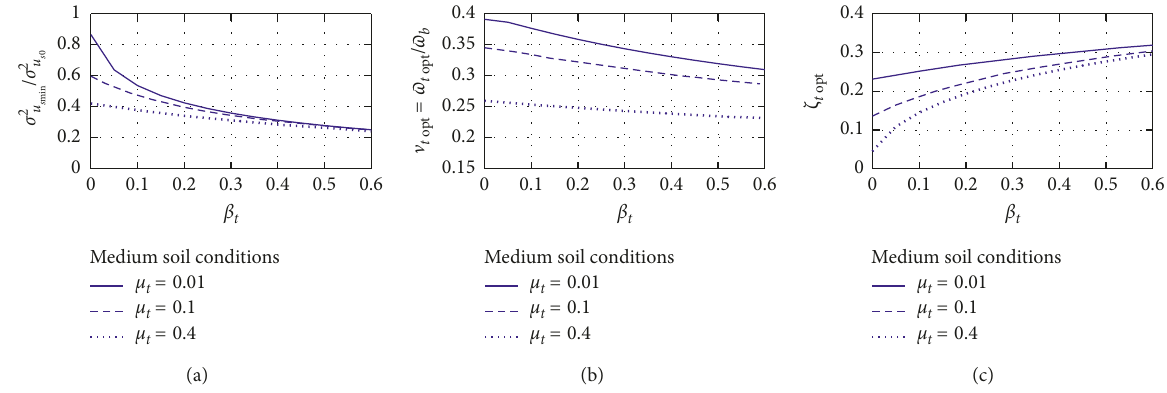
Figure 7: Optimal TMDI tuning for medium soil conditions: (a) minimum OF achieved, normalized with respect to the case without TMDI; (b) optimal frequency ratio; (c) optimal damping